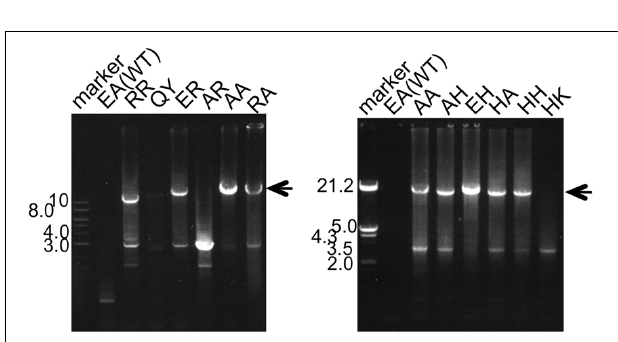
FIGURE 7 | PCR performances of WT and mutant Taq polymerases. Lambda DNA was used as the template. Twenty nanograms of the template DNA and 5 pmol of each primer were added to the standard PCR mixture (total volume 20 μ l, with 10mM Tris-HCl, pH 8.8, 50mM